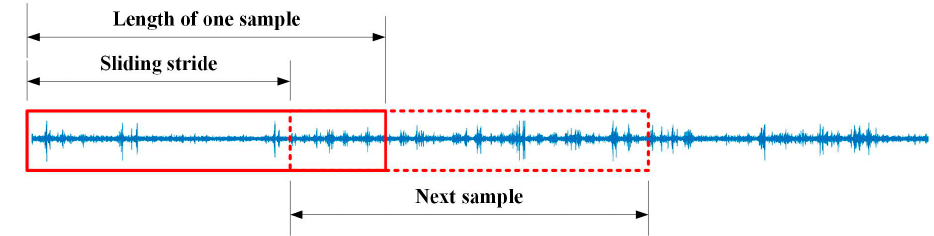
Figure 8. Diagram of the data augmentation.